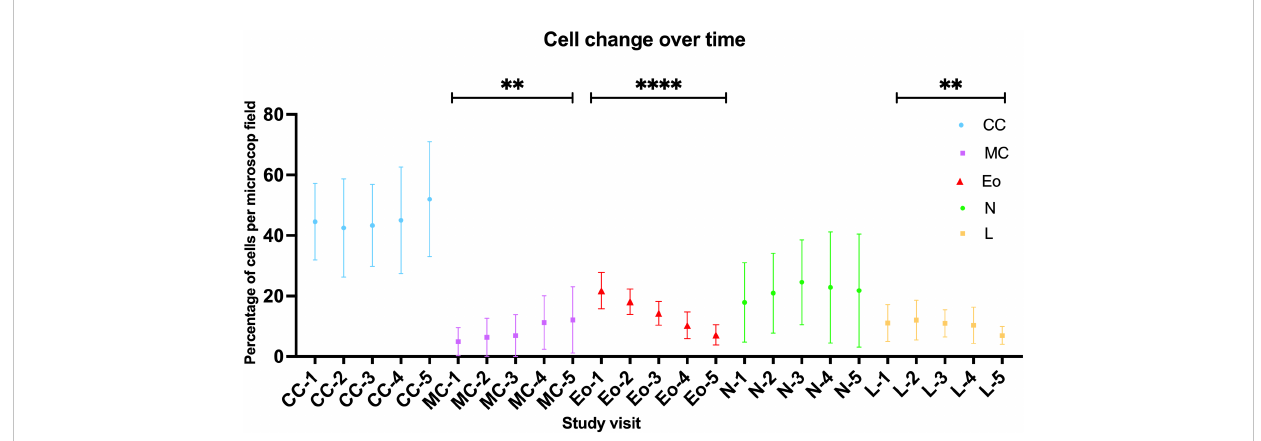
FIGURE 5 Change of cellular patterns in nasal swab cytology over time as detected by MGG-staining. CC, ciliated cells; MC, mucinous cells; Eo, eosinoiphil granulocytes; N, neutrophil granylocytes; L, lymphocytes; numbers indicate study visit (1-5). For all cells the mean +/- standard deviation is indicated by a symbol with respective error bars; One-way ANOVA/Friedman test. ****-p<0.0001,